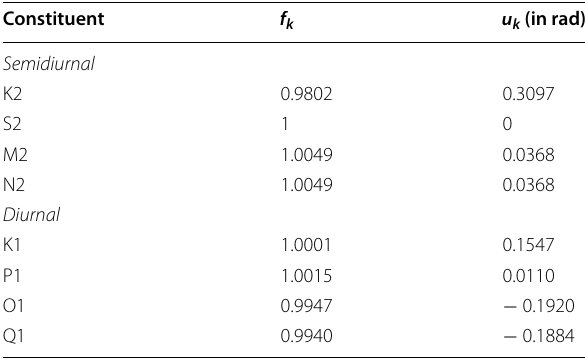
Table 3 Amplitude and phase modulating factors f k and u